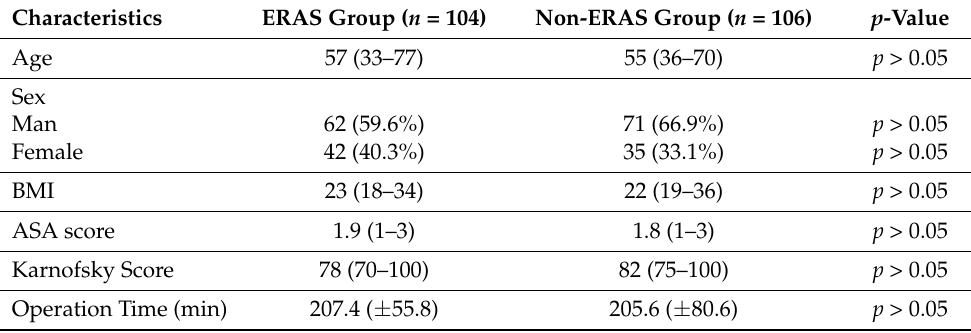
Table 2. Demographic data of